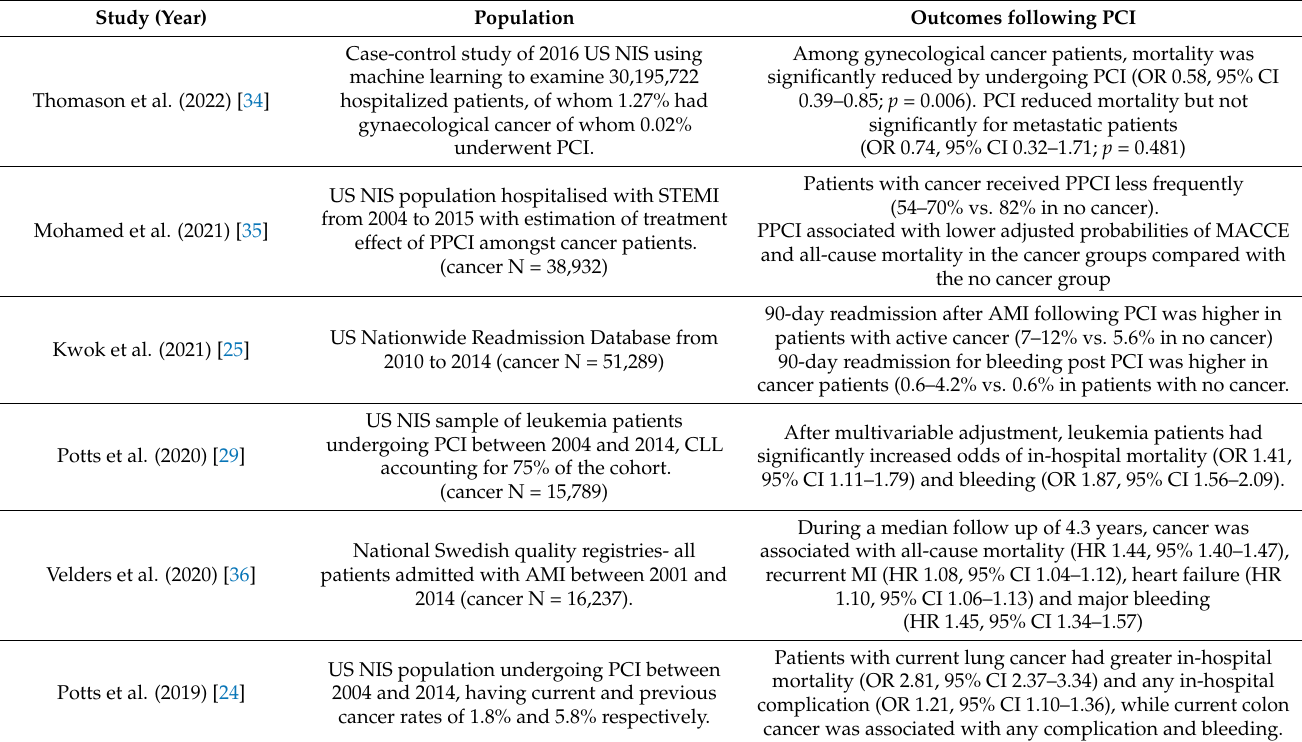
Table 1. Summary of recent studies looking at outcomes following PCI amongst cancer